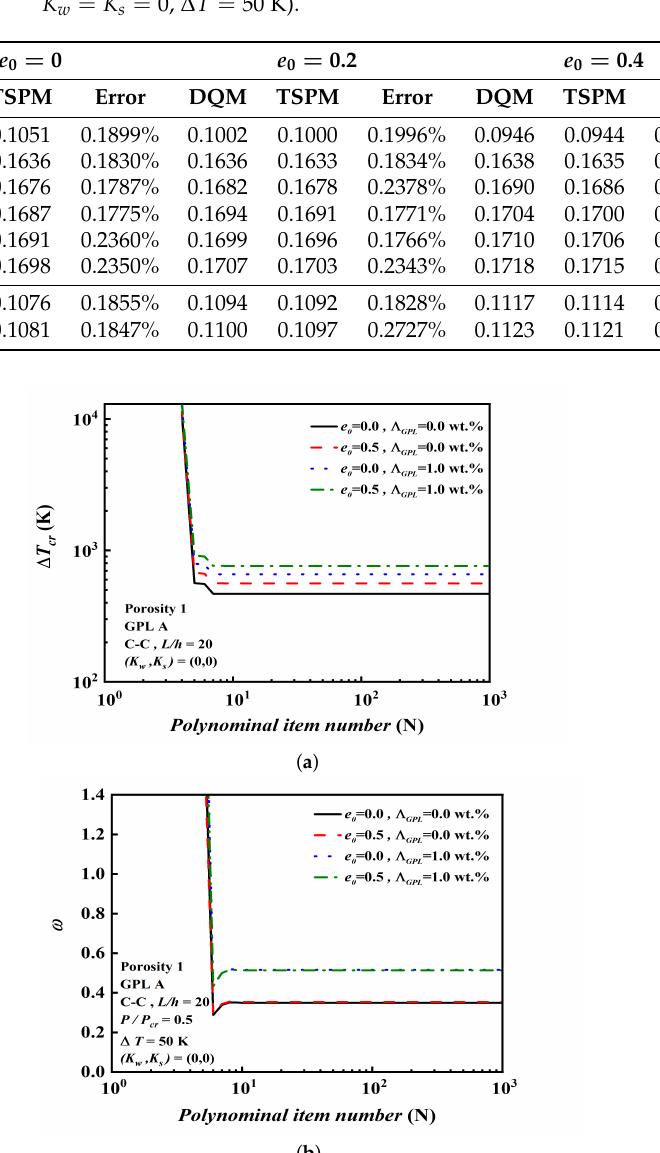
Table 4. The dimensionless fundamental frequency of H-H beams (porosity 1, GPL A, L / h = 20, K w = K s = 0, ∆ T = 50 K).